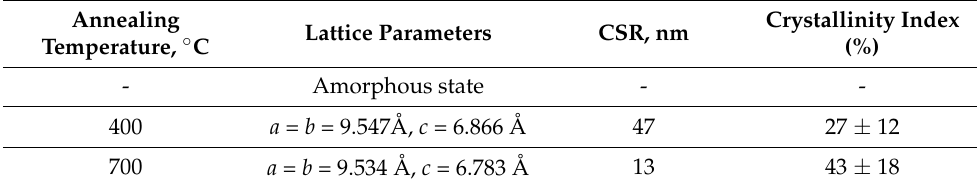
Figure 19. XRD-patterns of Cu-HA coating on Ti as-deposited ( a ), after annealing at 400 °C for 3 h ( b ), and after HT at 700 °C for 3 h ( c ) (red, blue, and gray lines represent HA (red) and Ti (blue) etalon XRD patterns according to PDF-card no. 00-009-0432 and 00-044-1294, respectively). Table 5. Crystalline lattice parameters in the structure of Cu-HA coatings obtained by sputtering Cu-HA target on Ti substrates after annealing at 400 or 700 ◦ C, 3